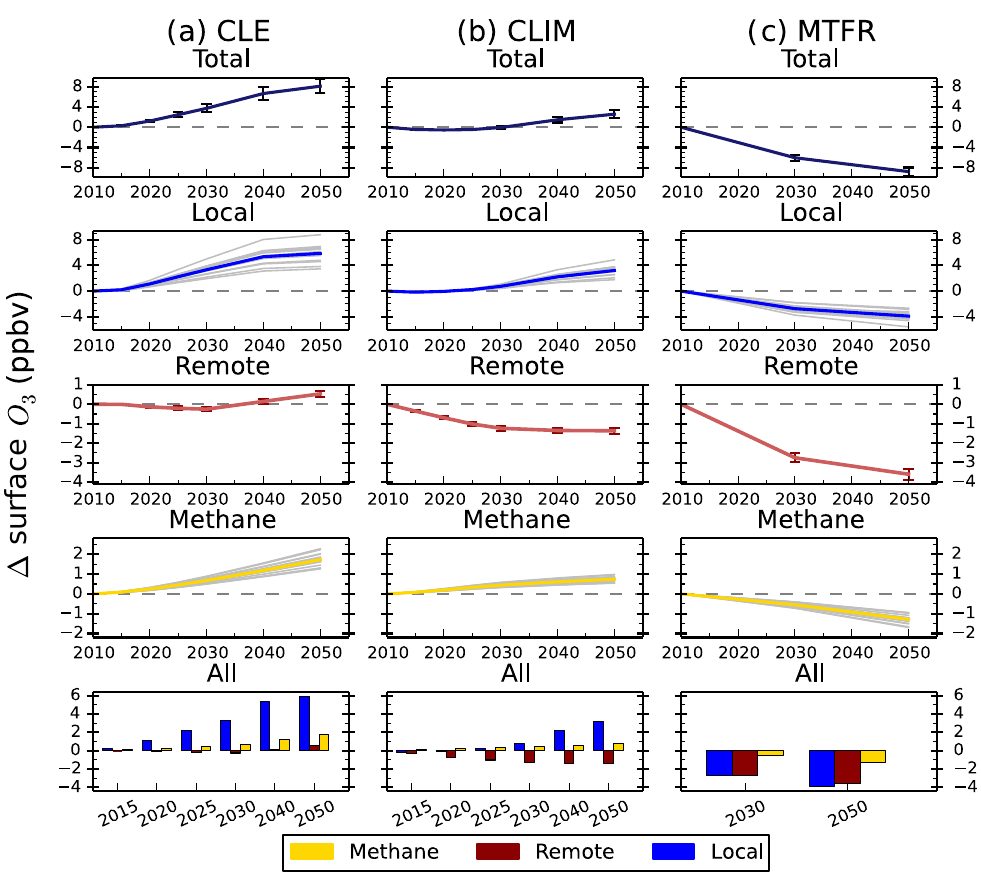
Figure 8. Same as Fig. 7 but for the south Asia region. Table 9. Percentage change in global CH 4 abundance and global and regional NO x emissions relative to 2010 over each TF-HTAP2 region for the different CMIP6 emission scenarios (SSP1 2.6, SSP2 6.0 and SSP3 BASE). Annual total emission change (%) from 2010 SSP1 2.6 SSP2 6.0 SSP3